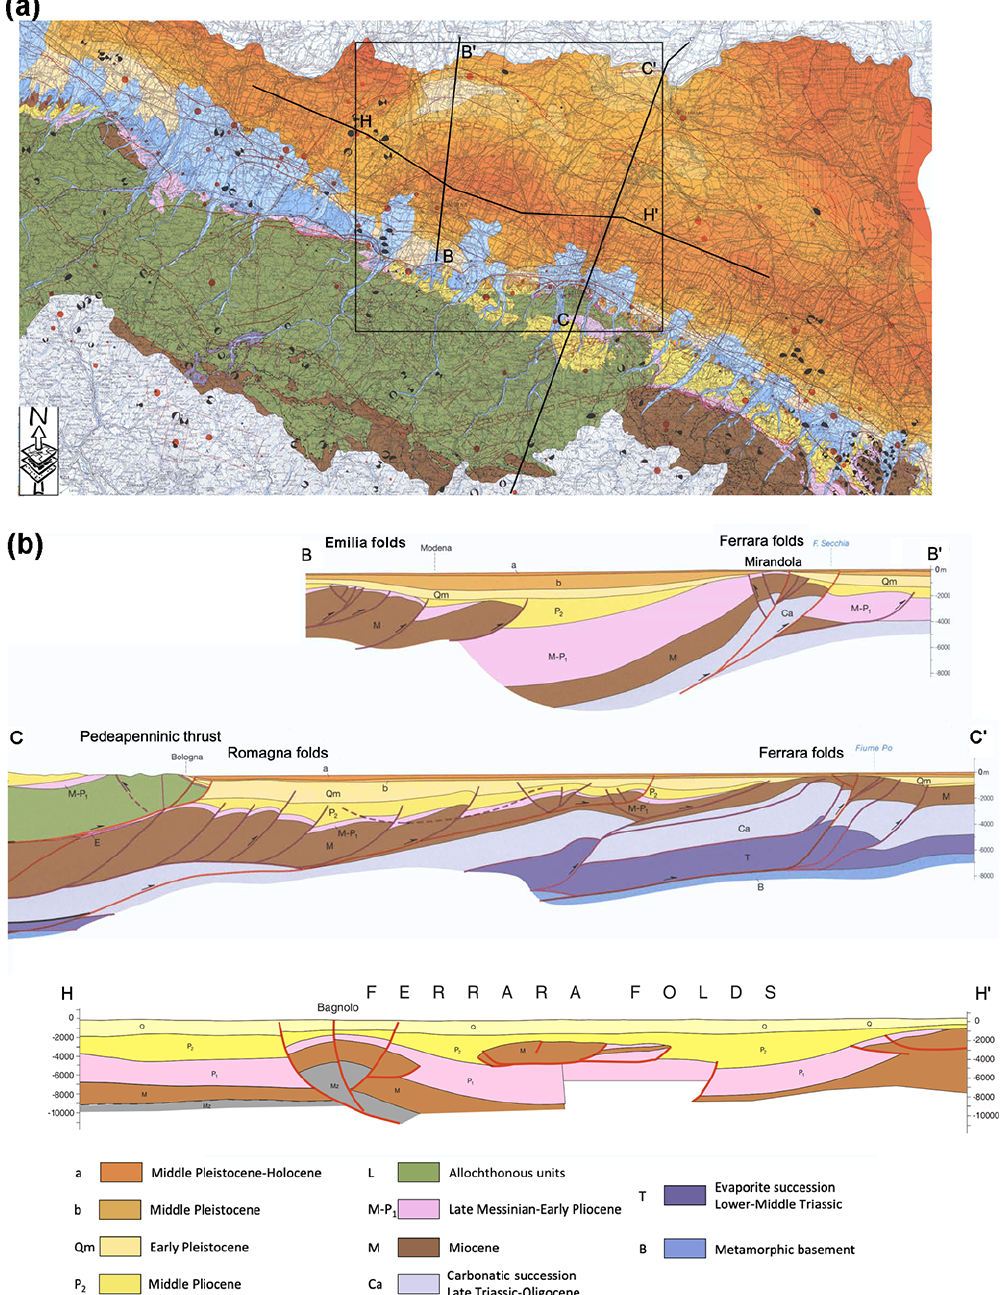
Figure 2. (a) Portion of the seismotectonic map. Black lines represent the three geological section traces. (b) Geological cross-sections from the Apennine–Po Plain margin to the Po River (from Boccaletti et al., 2004).